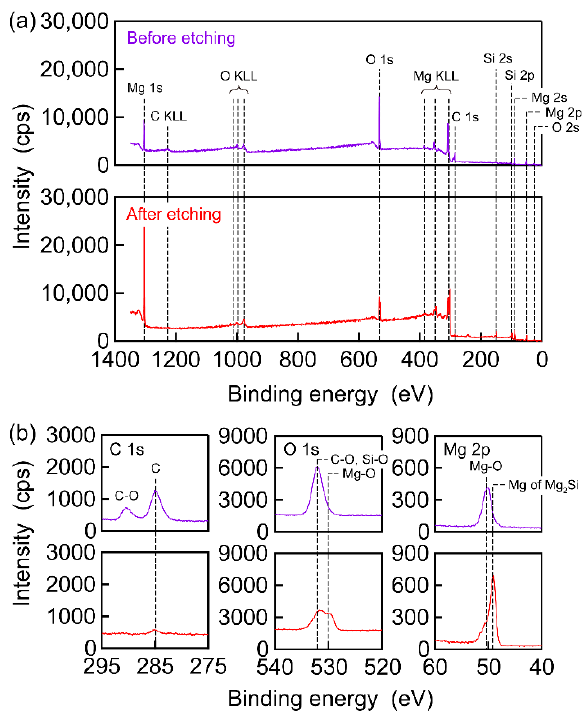
Figure 4. ( a ) X-ray photoelectron spectroscopy survey spectra and ( b ) core level spectra of the Mg 2